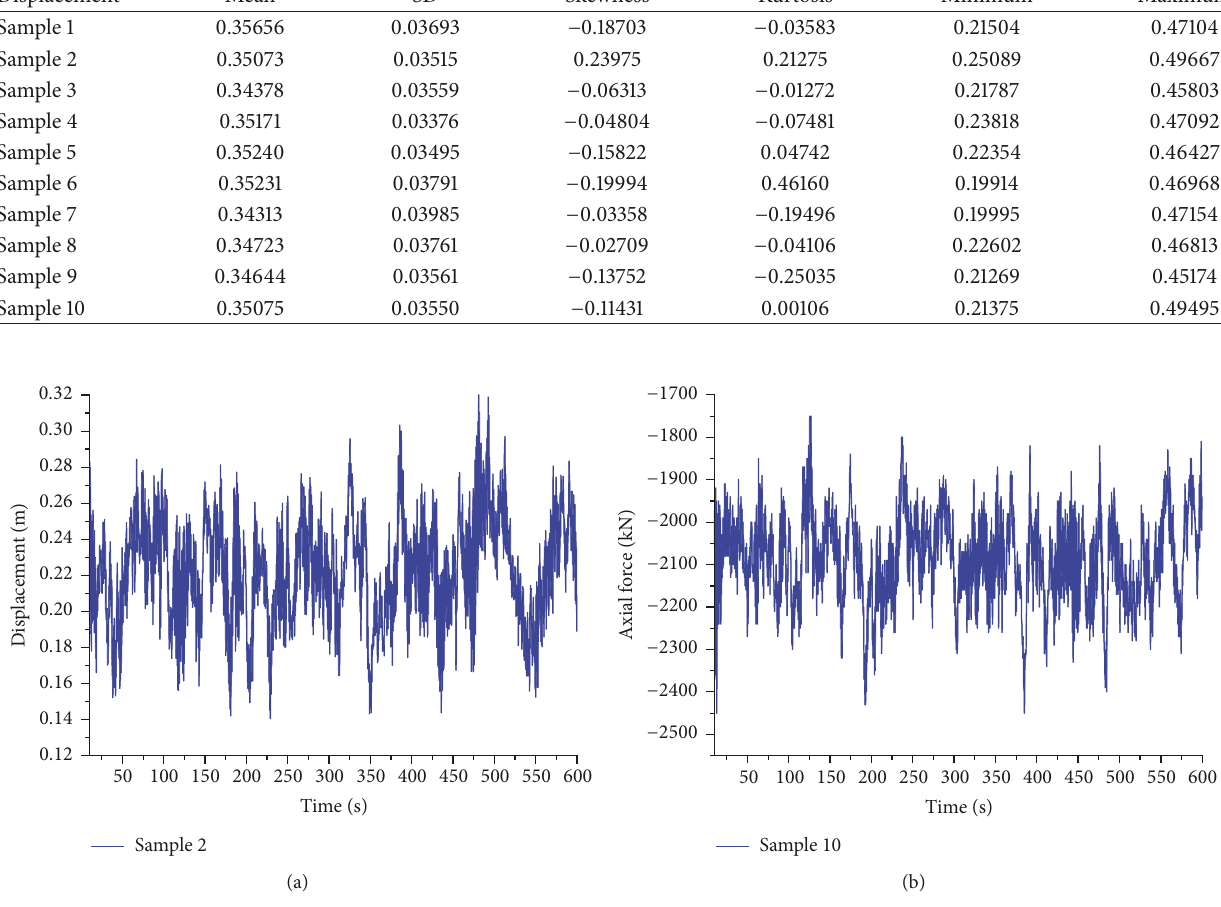
Figure 9: Time history curve of single low tower under wind field 2.